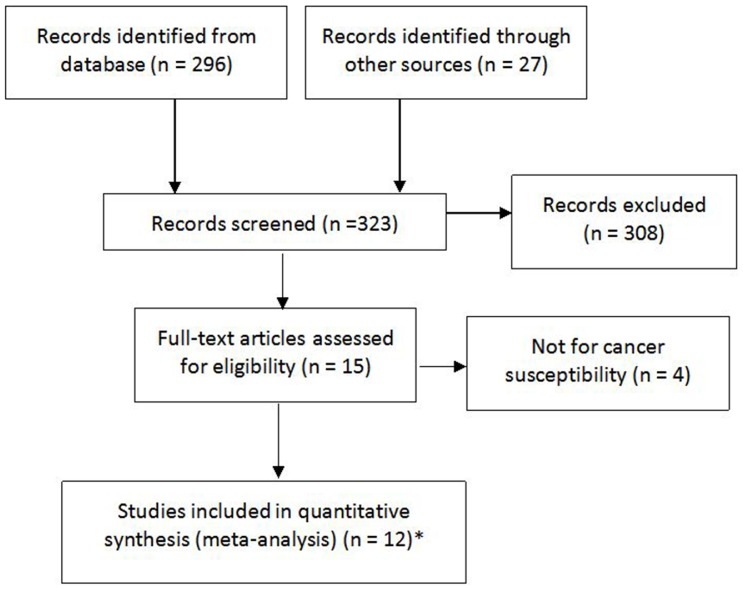
PRISMA Flow Chart.*a total of 11 articles were identified and two separate studies were reported in one articles, thus 12 studies were eligible.